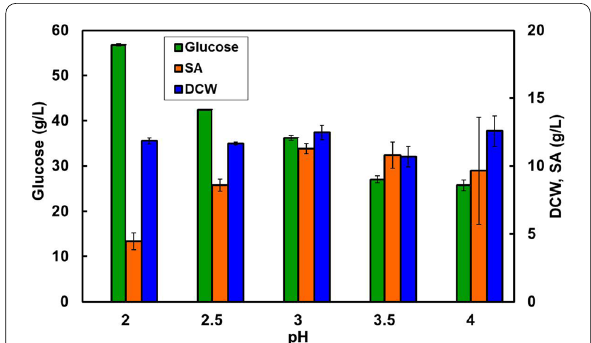
Fig. 5 Effect of initial pH on spiculisporic acid production by T. trachyspermus NBRC 32238. The medium was adjusted to an initial pH of 2.0–4.0, and the strain was cultured with 100 g/L glucose at 28 °C for 7 days. Error bars indicate standard deviations from three independent experiments